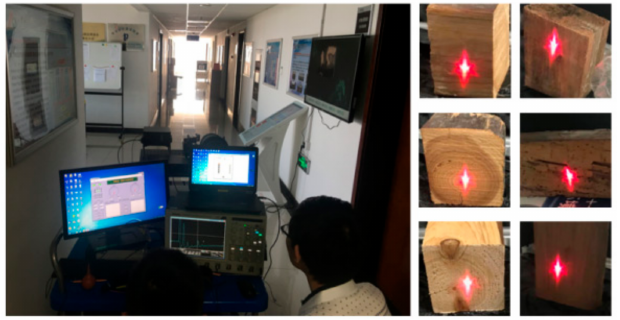
Figure 4. The data collecting experiment and some timber samples under